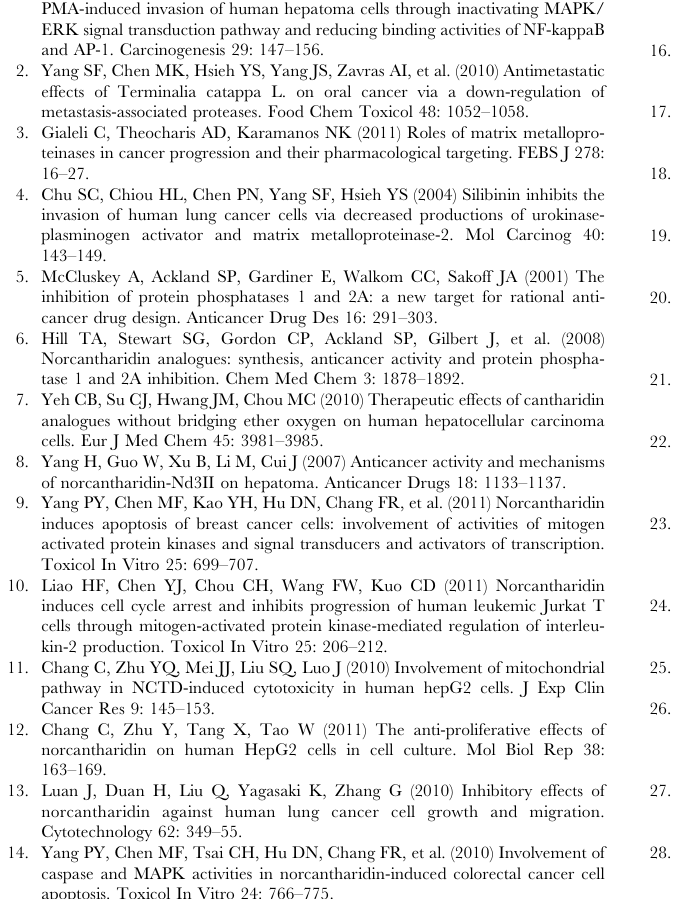
Figure S4 Effects of NCTD on the MMP-9 activity in SK- Hep1 cells. SK-Hep1 cells were treated with NCTD (0 , 10 m M) for 24 h and then subjected to gelatin zymography to analyze the activity of MMP-9. The values represented the means 6 SD of at least three independent experiments. *P , 0.05 as compared with the vehicle group. (JPG) Figure S5 Effects of NCTD on the FAK expression in Huh7 cells. Huh7 cells were treated with NCTD (0 , 10 m M) for 24 h and then subjected to Western blotting to analyze the expression of FAK. Table S1 Primers list for real-time PCR and ChIP